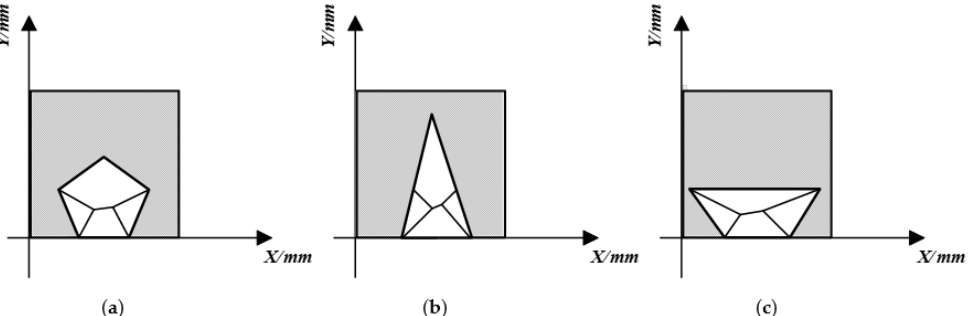
Figure 12. Restricted area of the six-bar mechanism. ( a ) Normal position, ( b ) Y-direction limit position, ( c ) X-direction limit position.